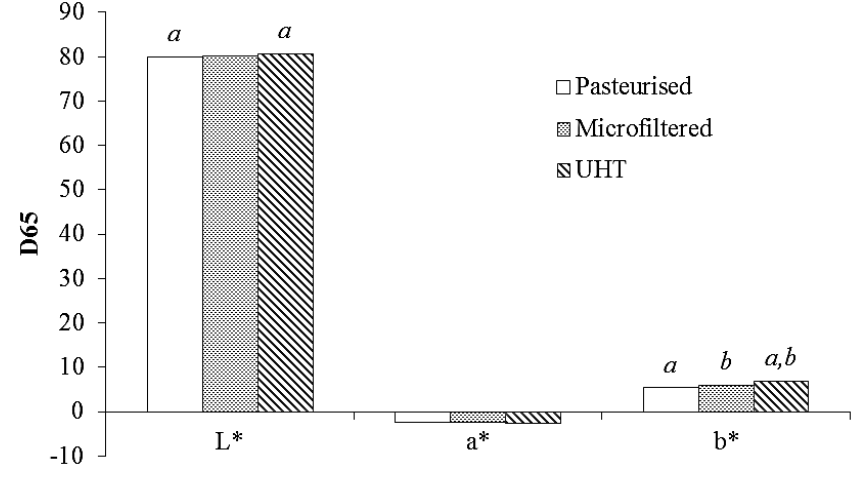
Figure 4. Instrumental determination of color ( L *, a *, b *) in whole commercial milk samples (pasteurized, microfiltered and UHT milk). Different superscript letters are significantly different ( p <